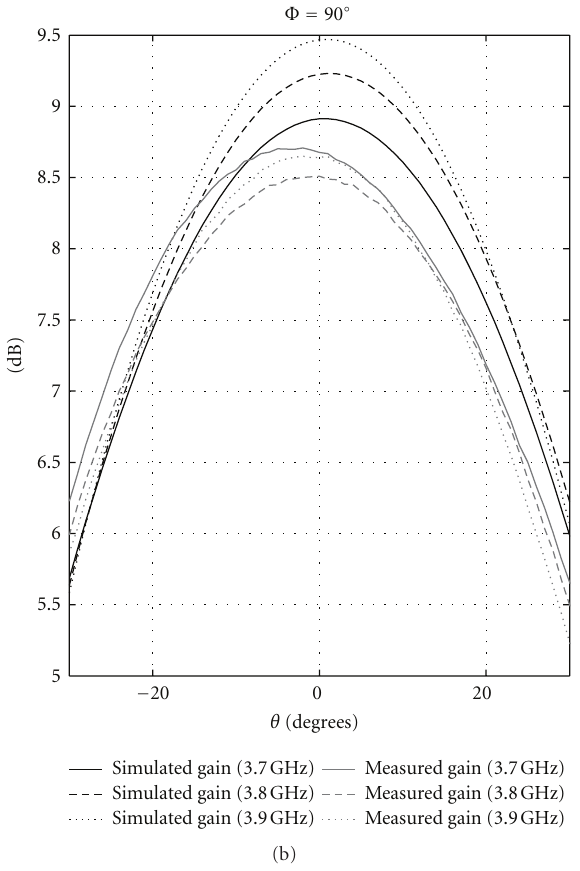
Figure 10: Simulated and measured realized gain obtained over the angular aperture in the two principal Φ planes (0 ◦ at left and 90 ◦ at